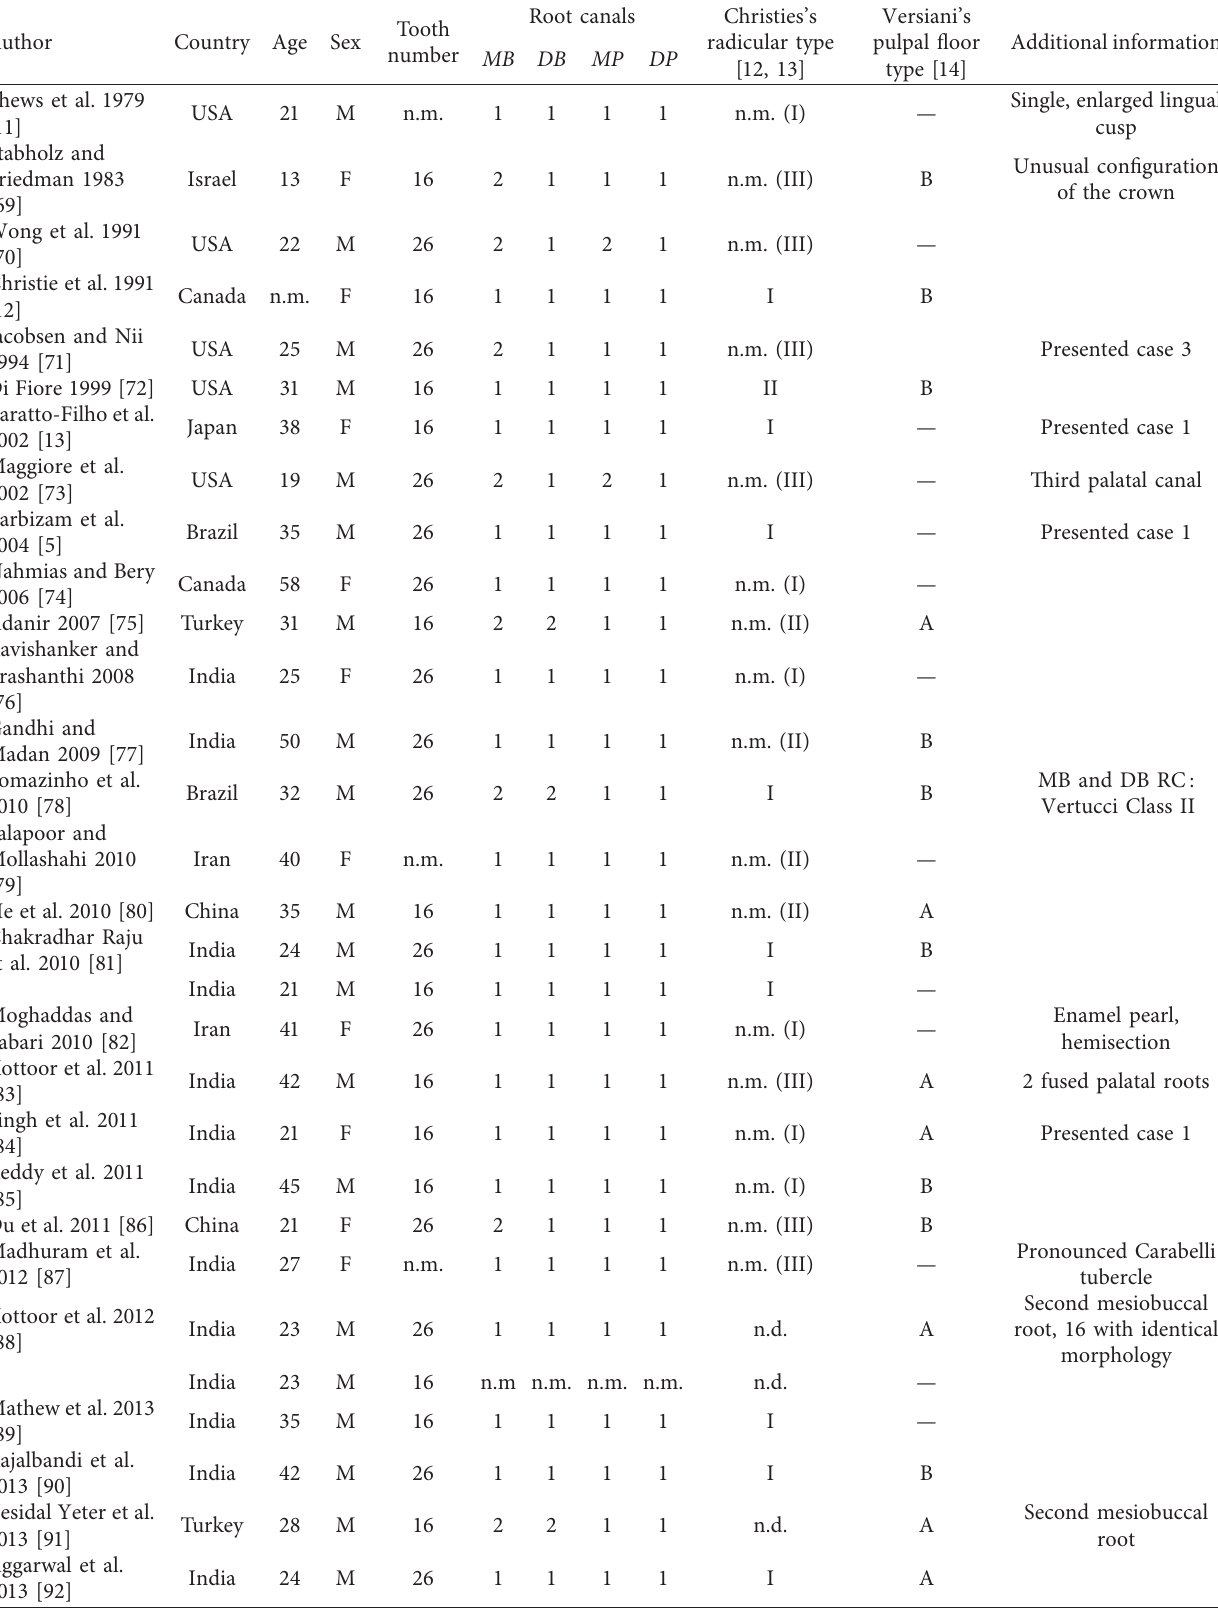
Table 2: Analysis of the case